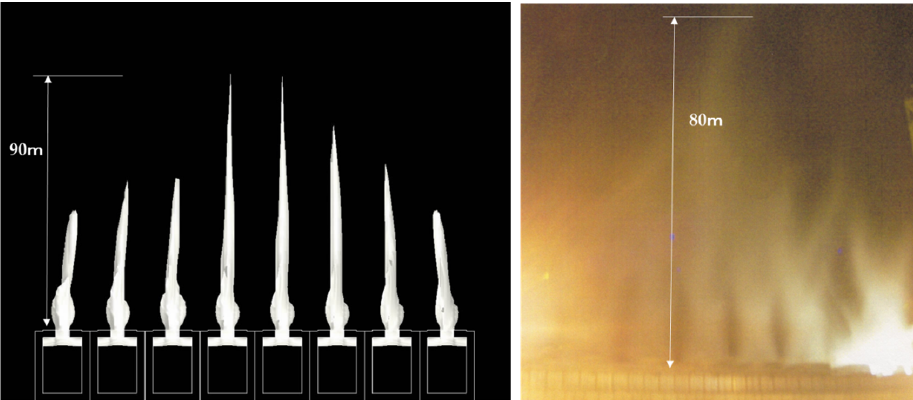
Figure 8. Comparisons of calculated and observed visible plumes under wet operation.